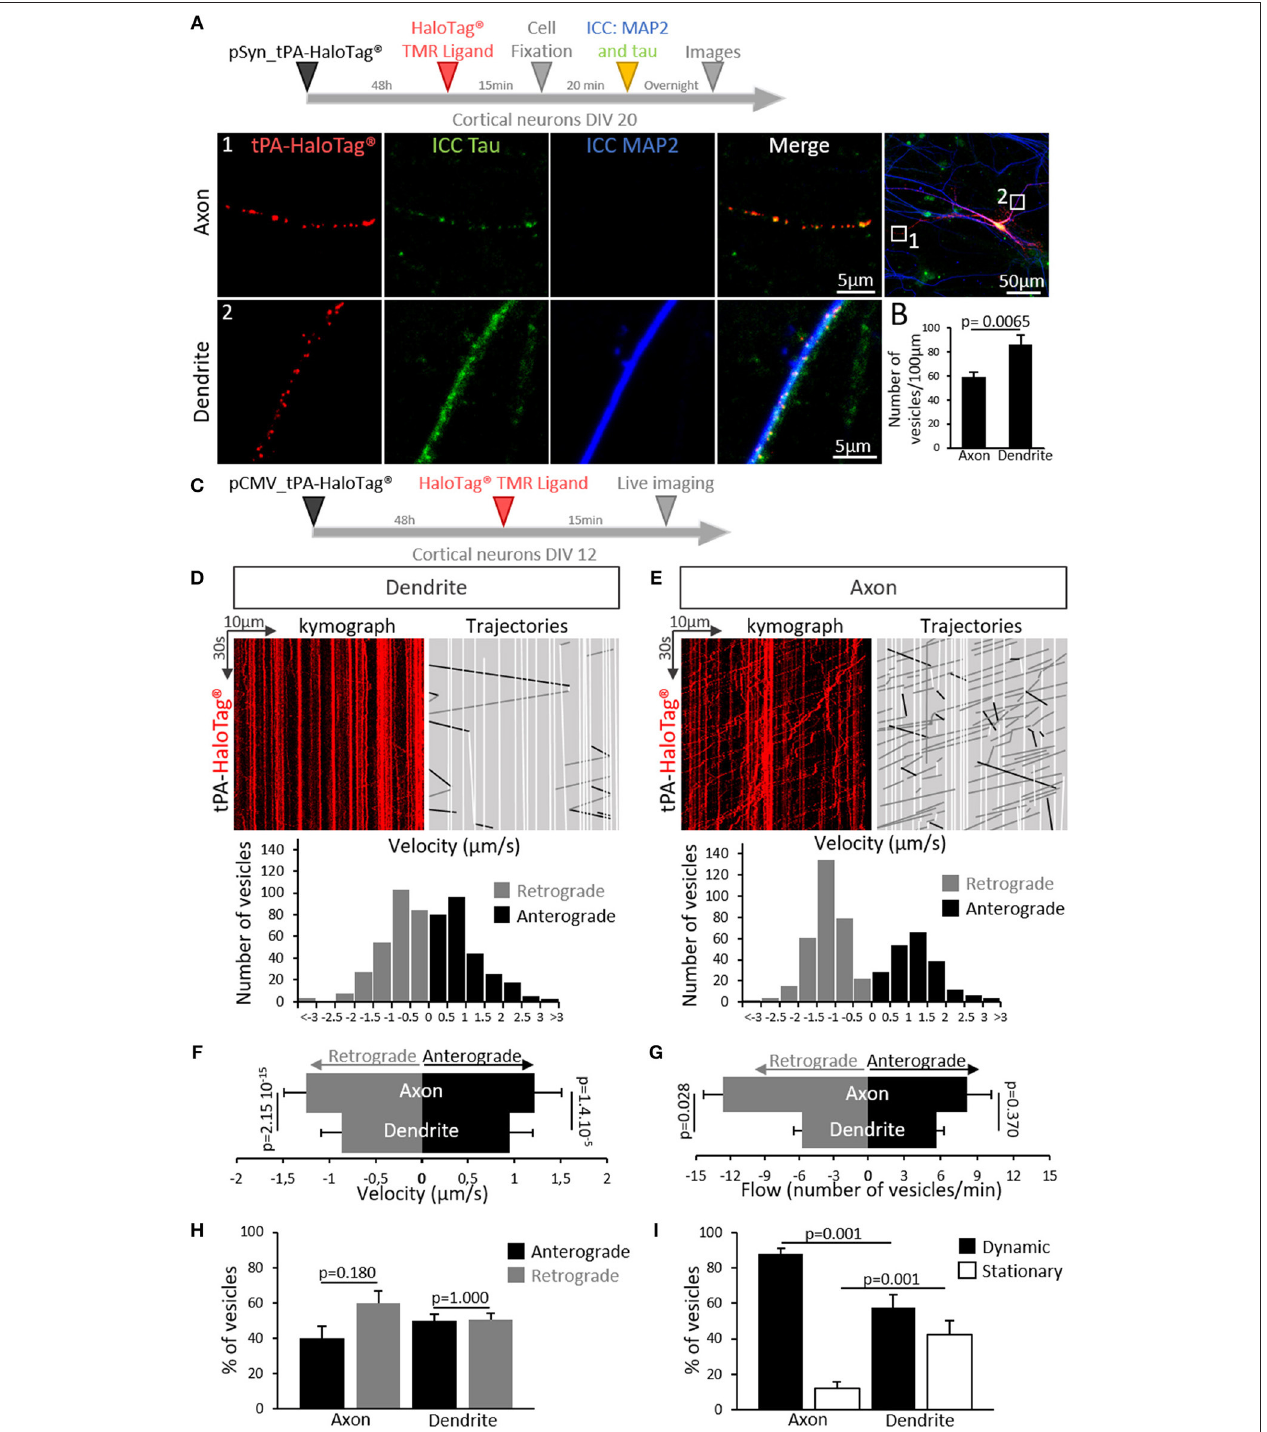
FIGURE 3 | tPA is present and transported in axons and dendrites. (A) Timeline of the experiments. Representative z-stack confocal images of cortical neurons (at DIV 20) transfected with pSyn_tPA-HaloTag ® , incubated in the presence of the HaloTag ® TMR ligand (in red) and subjected to immunocytochemistries raised against tau (tubulin-associated unit, in green) and MAP2 (microtubule associated protein 2, in blue). tPA-HaloTag ® is present in axons (1; MAP2 – and tau + ) and in dendrites (2; MAP2 + and tau + ). Scale Bar: 5 or 50 µ m (whole neuron). (B) Quantification of the number of TMR positive puncta per 100 µ m along the axons (59puncta/100 µ m) and dendrites (86puncta/100 µ m). n = 15and n = 22 neurons respectively, from N = 6 independent cultures; p = 0.0065. (C) Timeline of